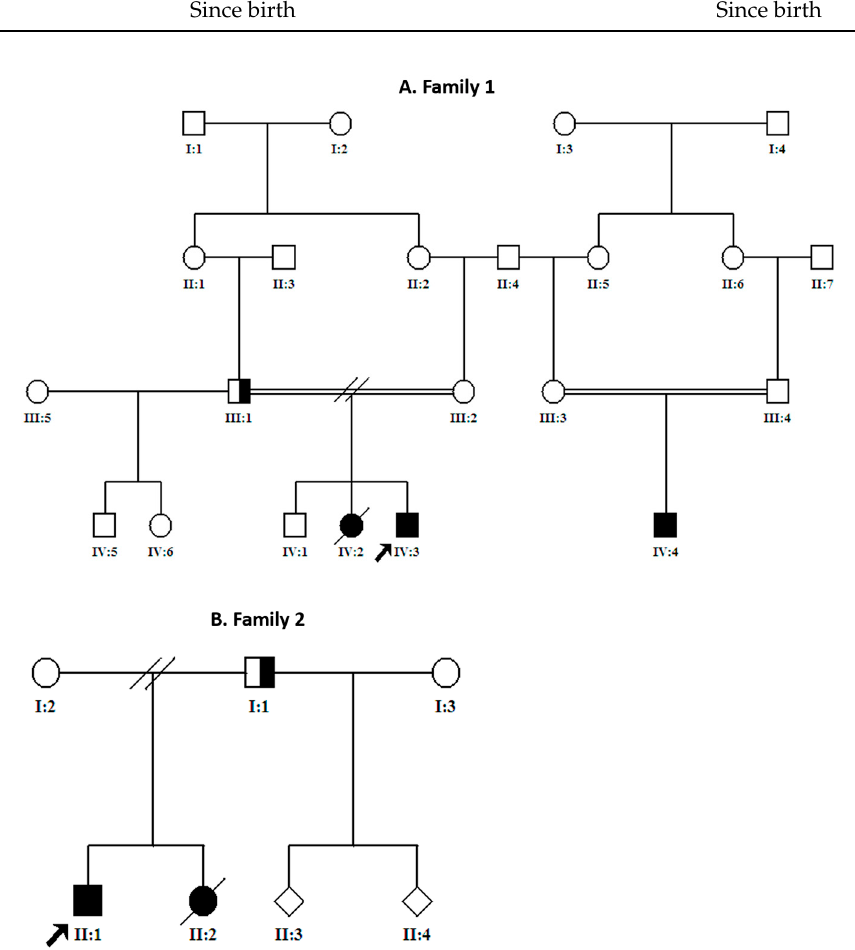
Figure 1. Family pedigrees indicating affected members. ( A ) Extended pedigree of the first family shows two branches of Table 2. IV3, and IV4). Among the patients, only the index case was genetically tested. ( B ) Pedigree of the second family shows two affected siblings in the family.